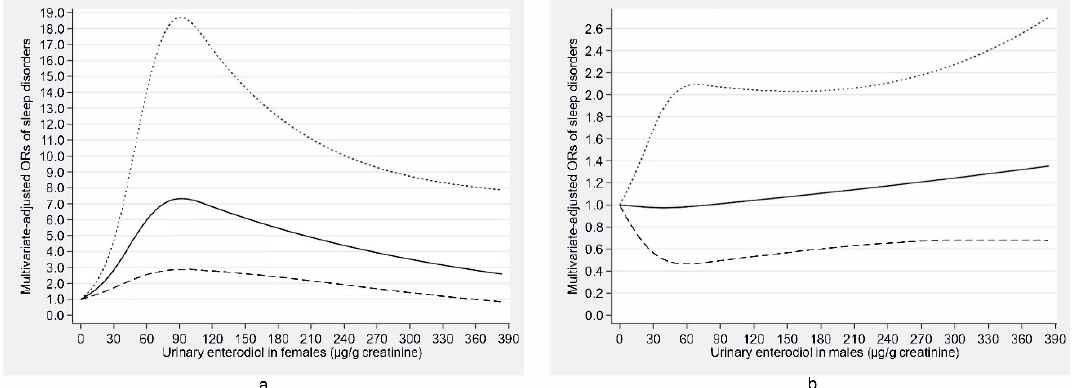
Figure 6. Concentration–response relationship of the urinary enterodiol concentration with sleep disorders for females ( a ) and males ( b ). The solid line represents the estimated odds ratios (ORs) and the dashed lines represent their 95% confidence intervals. The relationship adjusted for age, marital status, race, occupation, family income, educational level, body mass index, smoking status, alcohol consumption, use of female hormones (only in females), physical activity, caffeine intake, C-reactive protein, hypertension, depressive symptoms, diabetes, and the other five phytoestrogens (tertiles).